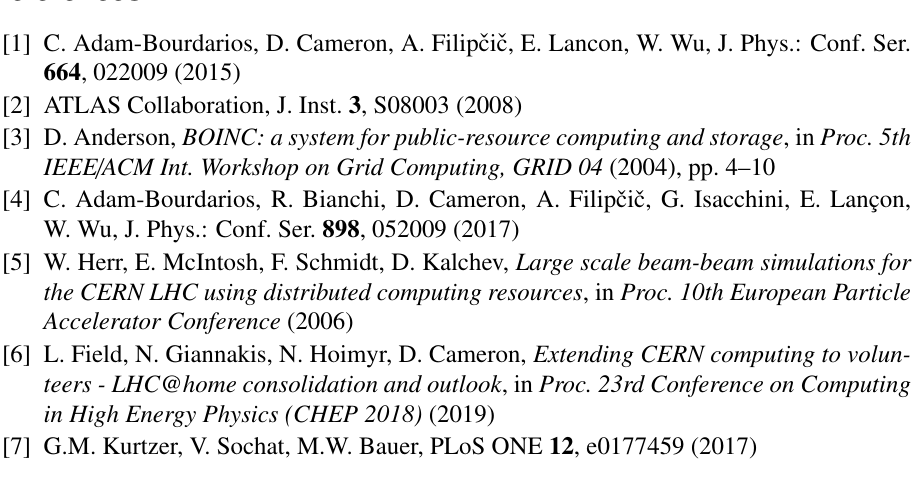
Figure 5. Integration of ATLAS Event Service into